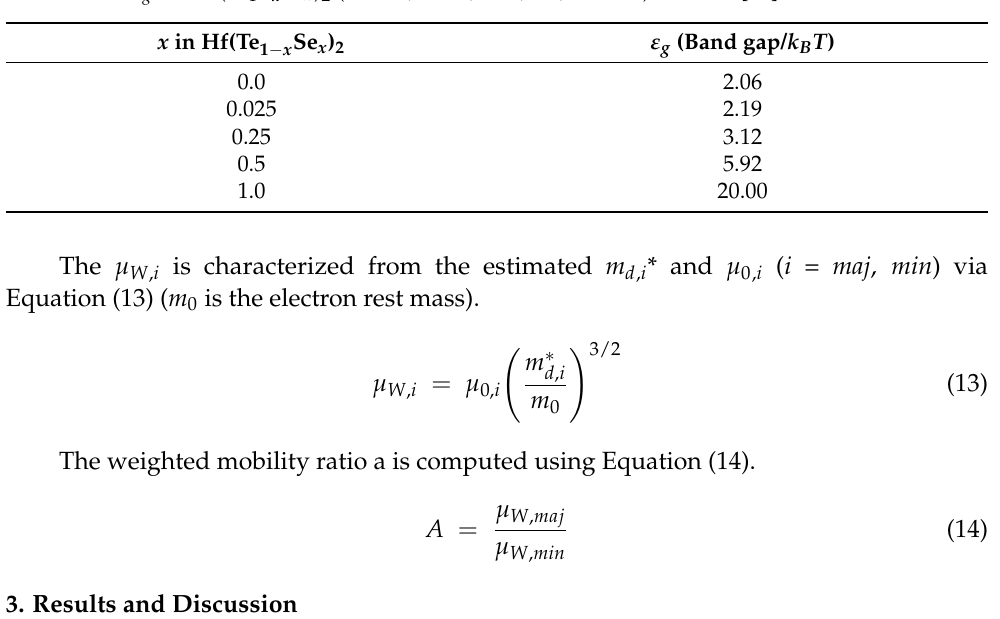
Table 1. The ε g for Hf(Te 1 − x Se x ) 2 ( x = 0.0, 0.025, 0.25, 0.5, and 1.0) at 300 K [22].